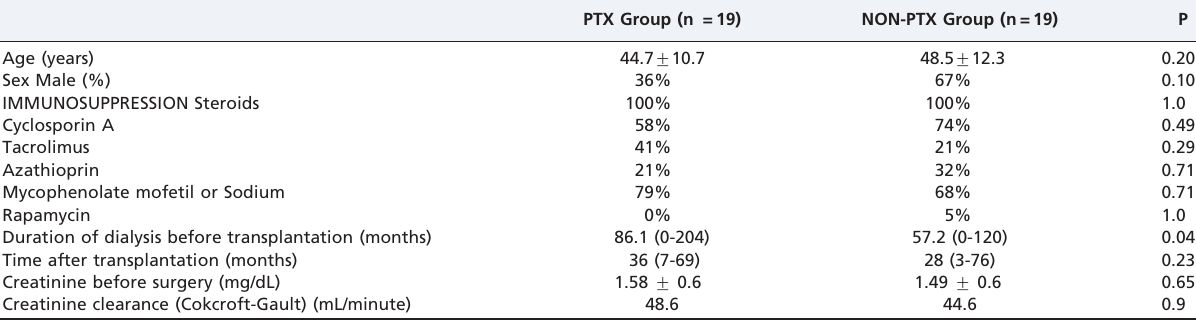
Table 1 - Demographic and clinical data.